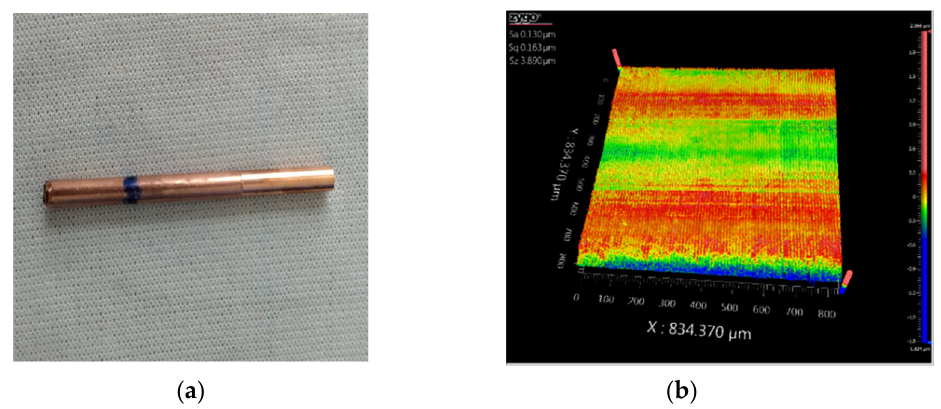
Figure 20. The finished workpiece and its test result. ( a ) Picture of the cutting copper bar; ( b ) surface morphology characterized by white light interferometer.